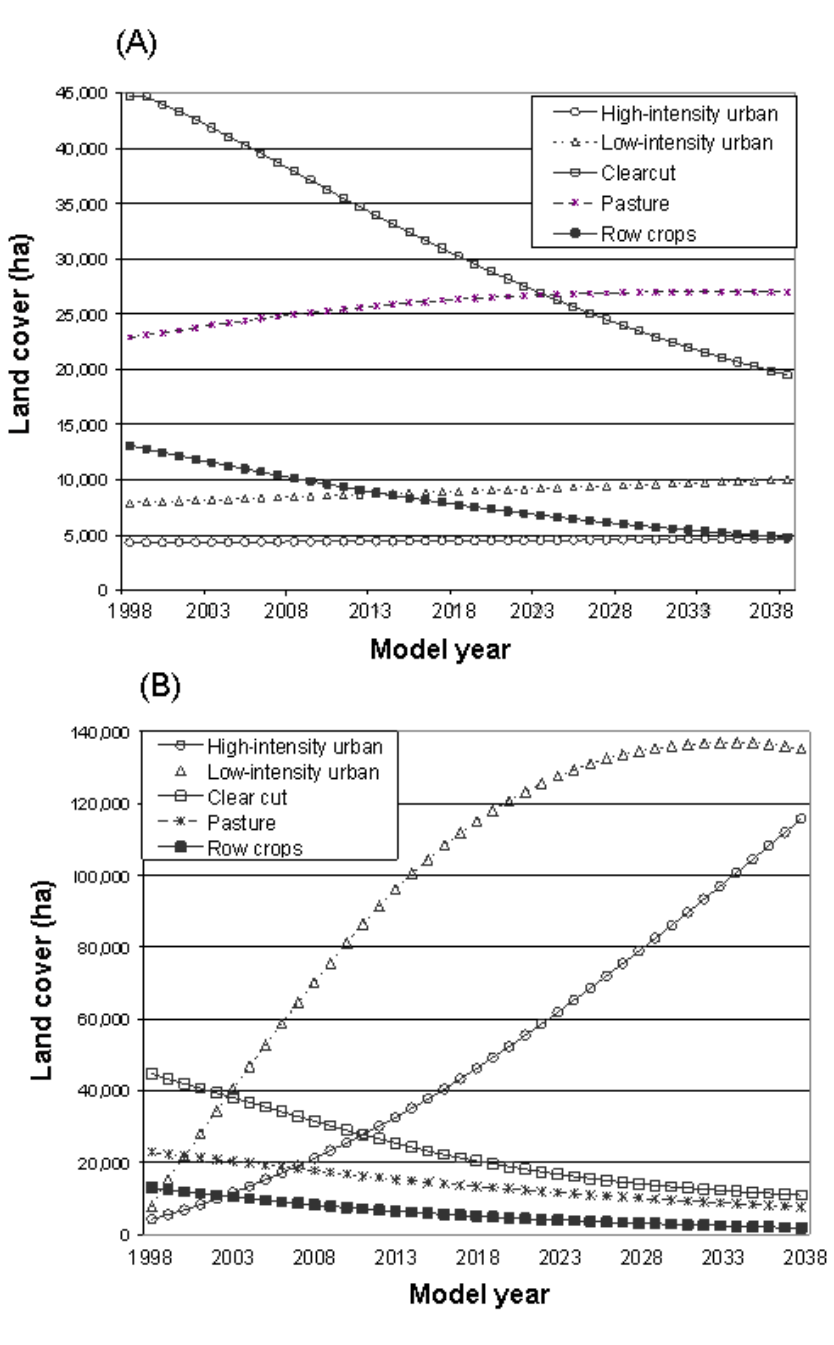
Fig. 4. Projected changes in urban land cover, pasture, and row crops over 40 yr for the (A) business as usual scenario and (B) high urban growth